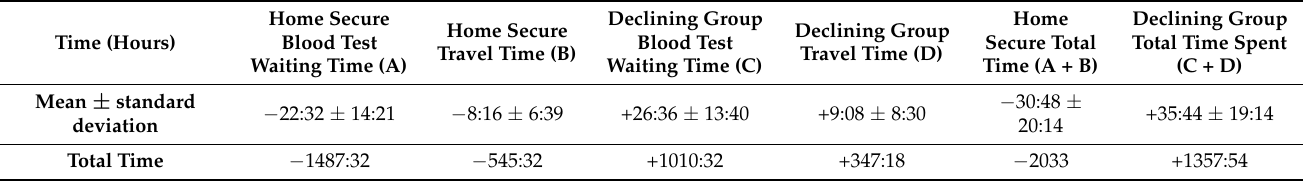
Table 5. Time (hours:minutes) saved or spent according to the Home Se-Cure group and declining group. Negative values represent time saved and positive values time